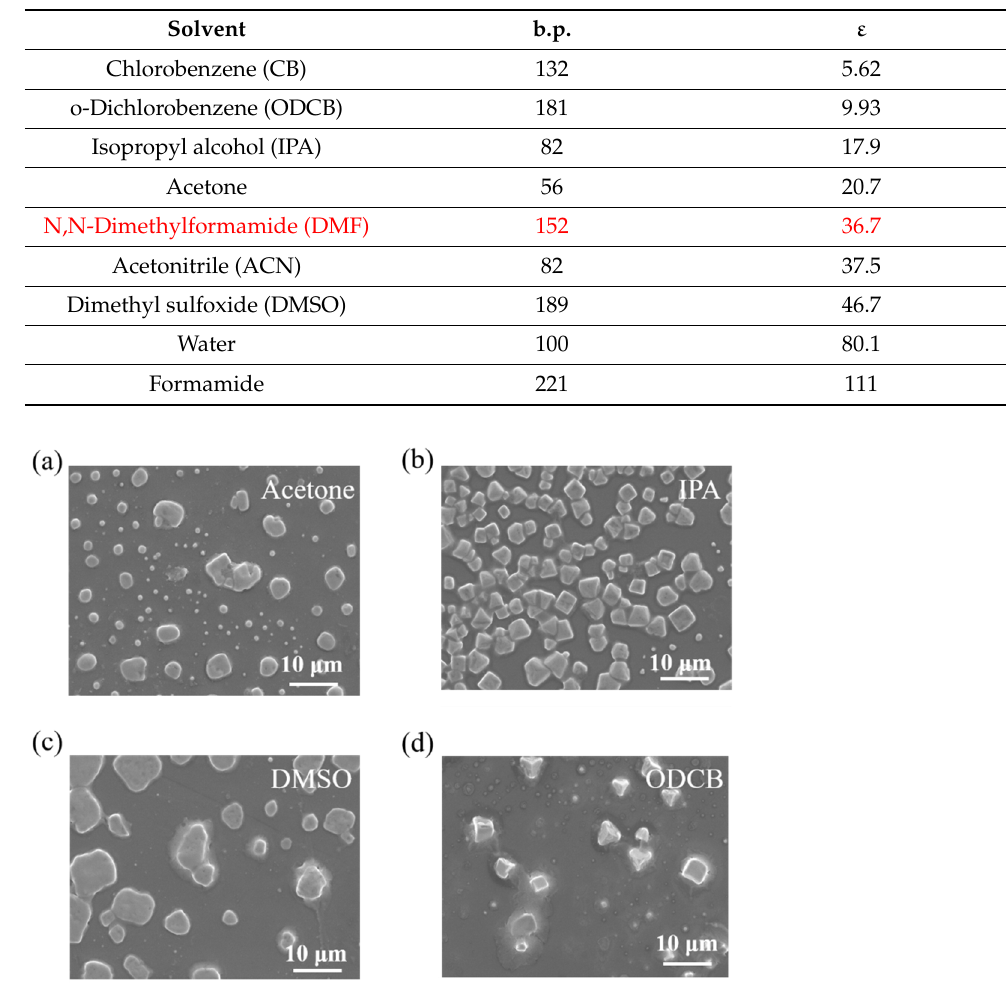
Table 1. Dielectric constant ( ε ) and boiling point (b.p.) of the commonly used solvents.